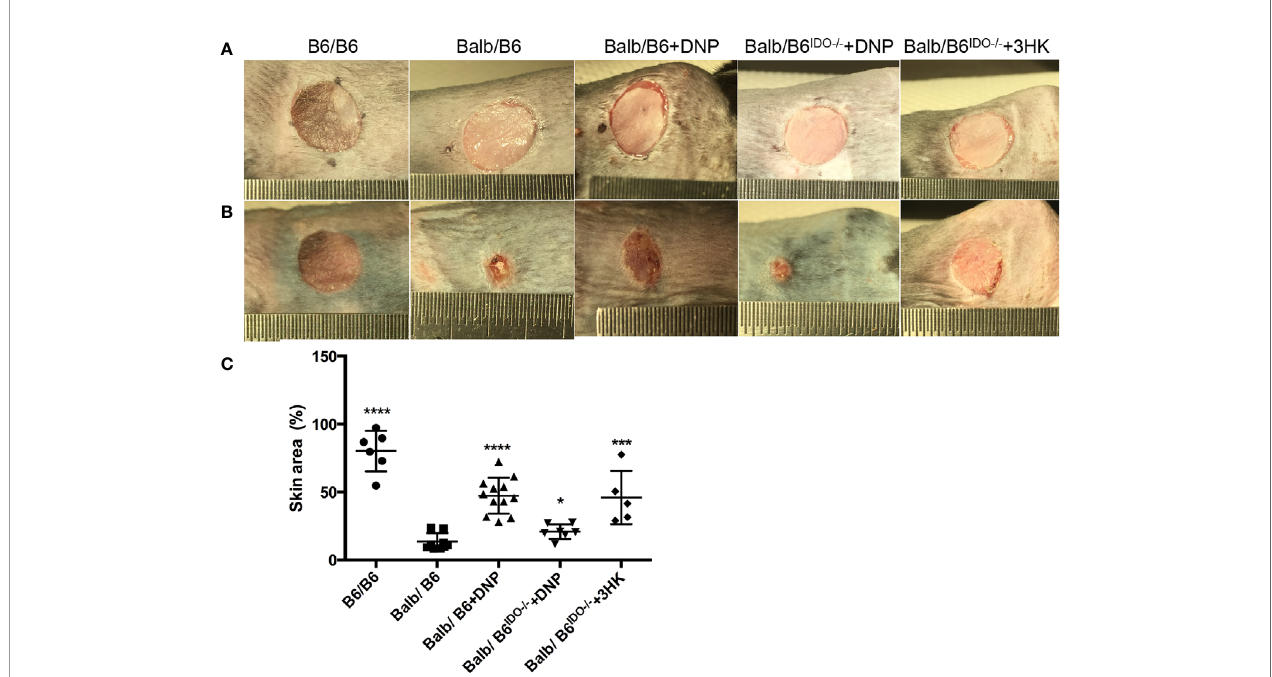
FIGURE 8 | Tolerance effect of kynurenine and its metabolic derivatives in skin graft rejection. (A) Eight-week-old B6 or IDO knockout (B6 IDO − / − , IDO-KO) recipients were transplanted with skin from donor Balb/c (Balbc) mice and treated with DNP or 3HK (i.p. injection) on day 0 (the day before operation). Each panel shows the appearance of donor ear skin tissues immediately following grafting onto the recipient on day 1 (operation day). (B) Skin grafts on day 14 from the same mice as (A) . (C) Graft remaining area in percent on day 14 compared to day 1 from different treatments. * P < 0.05, ***P < 0.001, **** P < 0.0001 versus Balb/B6; analysis is multiple one-way